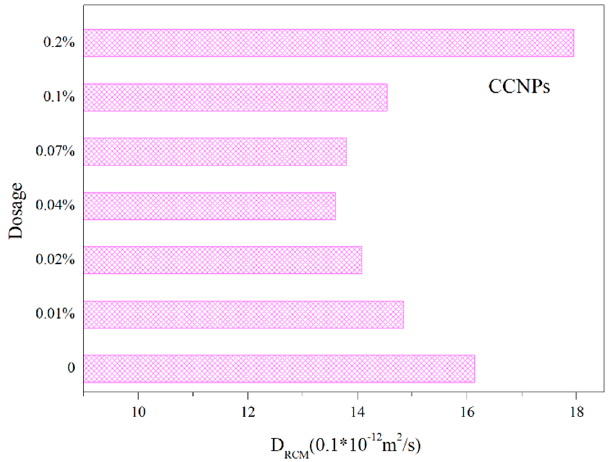
Figure 7. Chloride depth penetration results of cement mortar specimens with different amounts of CCNPs.